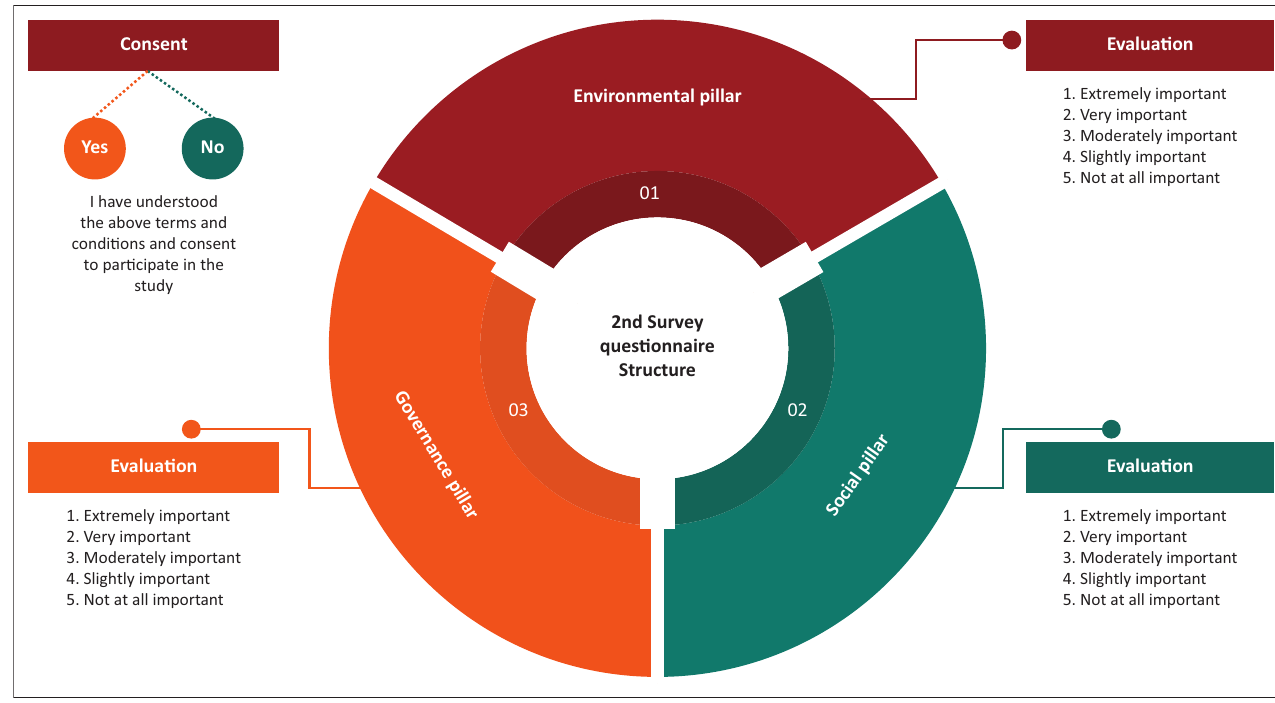
FIGURE 2: Five-point Likert scale – Second survey questionnaire